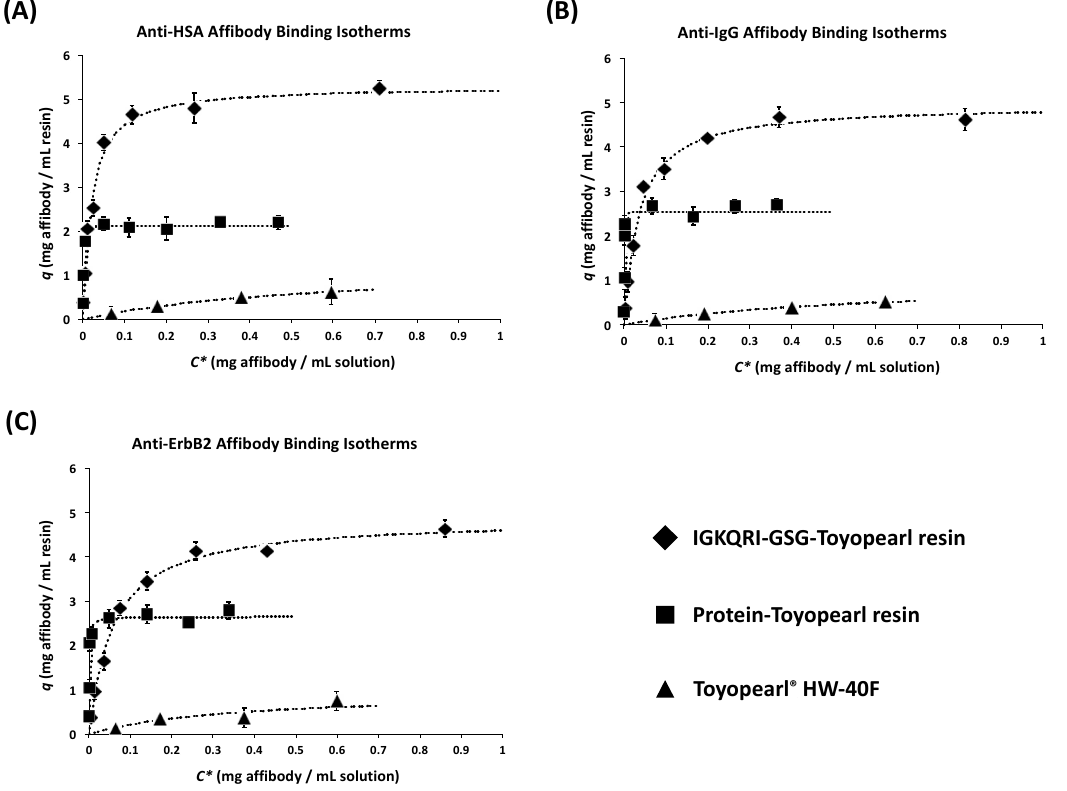
Figure 3. Adsorption isotherms of ( A ) anti-HSA affibody on IGKQRI–GSG–Toyopearl resin, HSA–Toyopearl, and Toyopearl ® HW-40F resins; ( B ) anti-IgG affibody on IGKQRI–GSG–Toyopearl resin, hIgG–Toyopearl, and Toyopearl ® HW-40F resins; ( C ) anti-ErbB2 affibody on IGKQRI–GSG–Toyopearl resin, ErbB2–Toyopearl, and Toyopearl ® HW-40F resins. Table 4. Fitting of isotherm data to the Langmuir adsorption model (TP: Toyopearl resin). Sequence